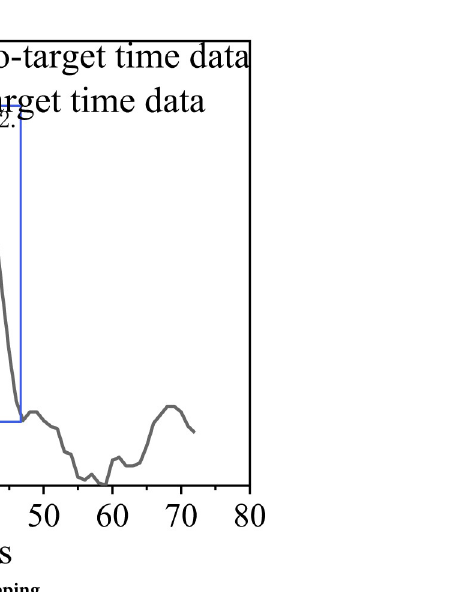
where T s and T s represent two sub-time-series data elements. k ; a k ; b The joint method is used to merge the two sub-time-series data elements. The combination of two overlapping sub-time-series data elements and the confidence calculation of the merged